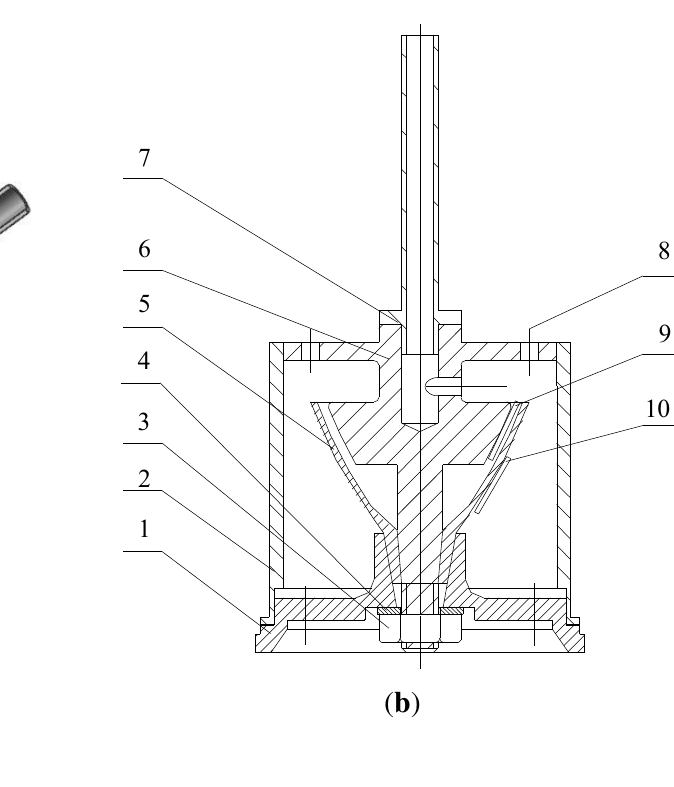
Figure 11. BVG sensor assembly unit: ( a ) 3-D sensor unit; ( b ) schematic